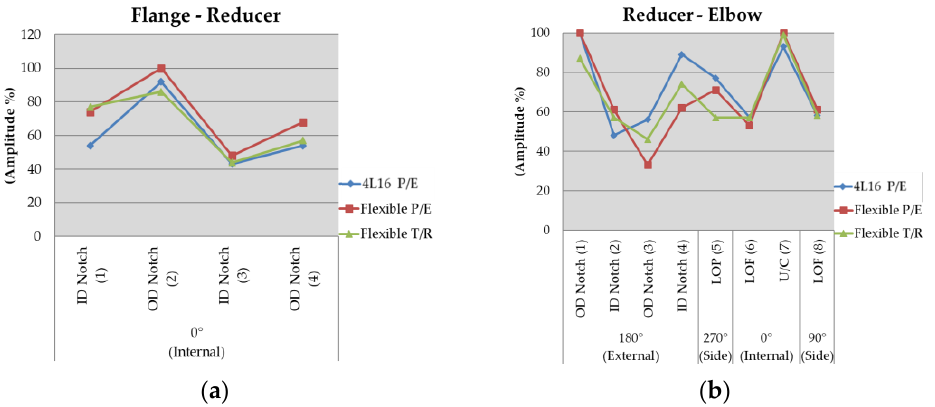
Figure 22. Flange – reducer – elbow specimen inspection results: ( a ) flange to reducer; ( b ) reducer to Figure 22. Flange–reducer–elbow specimen inspection results: ( a ) flange to reducer; ( b ) reducer elbow. to elbow.